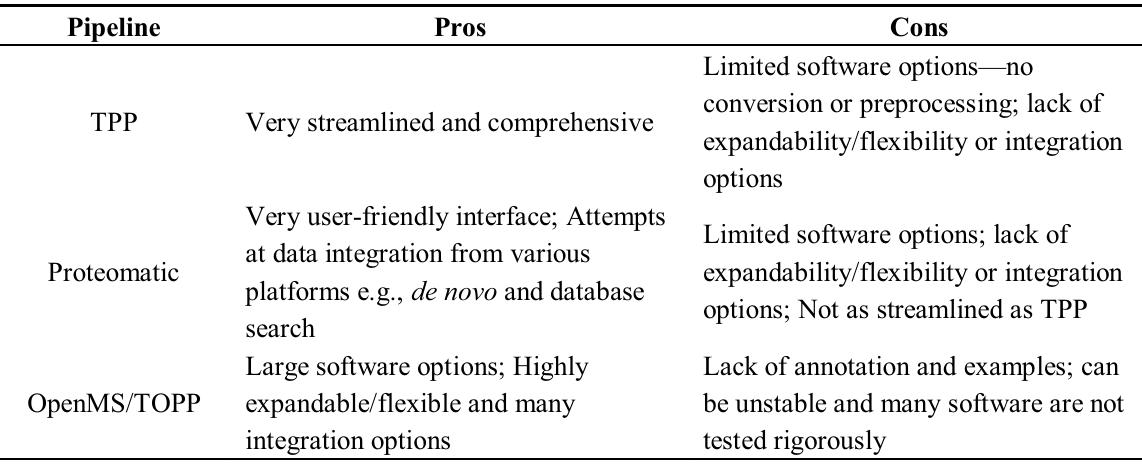
Table 1. Pros and Cons of the various Proteomics